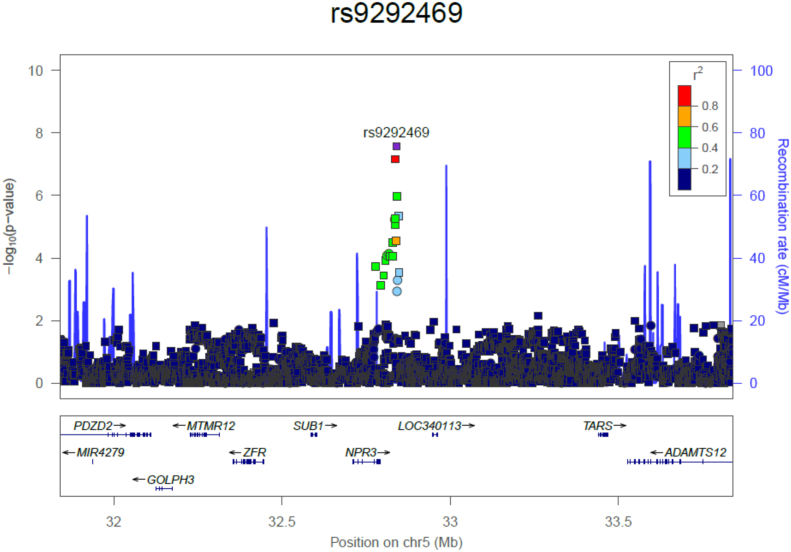
NPR3 regional association plot of the unexplained HBM, AOGC High BMD cases and AOGC Low BMD controls in a quantitative trait GWAS of lumbar spine BMD Z-Score, adjusted for age, age2 and centre (1000 kb either side of rs9292469 shown). Square symbols indicate imputed SNPs; circles indicate those genotyped.